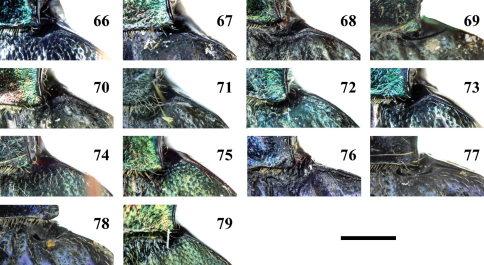
Humeral region of elytra of Chlaenius (Lithochlaenius) spp66 Chlaenius chuanqianensis sp. n., holotype67 Chlaenius linwensini sp. n., holotype68 Chlaenius propeagilis sp. n., holotype69 Chlaenius agilis Chaudoir, holotype70 Chlaenius formosensis Lorenz, CCCC71 Chlaenius leishanensis Kirschenhofer, IZCAS72 Chlaenius noguchii Bates, IZCAS73 Chlaenius  wrasei Kirschenhofer, IZCAS74 Chlaenius agiloides Jedlička, IZCAS75 Chlaenius rambouseki Lutshnik from Ussuri region, ZCAS76 Chlaenius anchomenoides Bates, paratype77 Chlaenius nuristanus Jedlička, paratype78 Chlaenius nuristanus Jedlička, paratype79 Chlaenius rambousekiLutshnik from Taiwan, CCCC. Scale line = 1.0 mm.